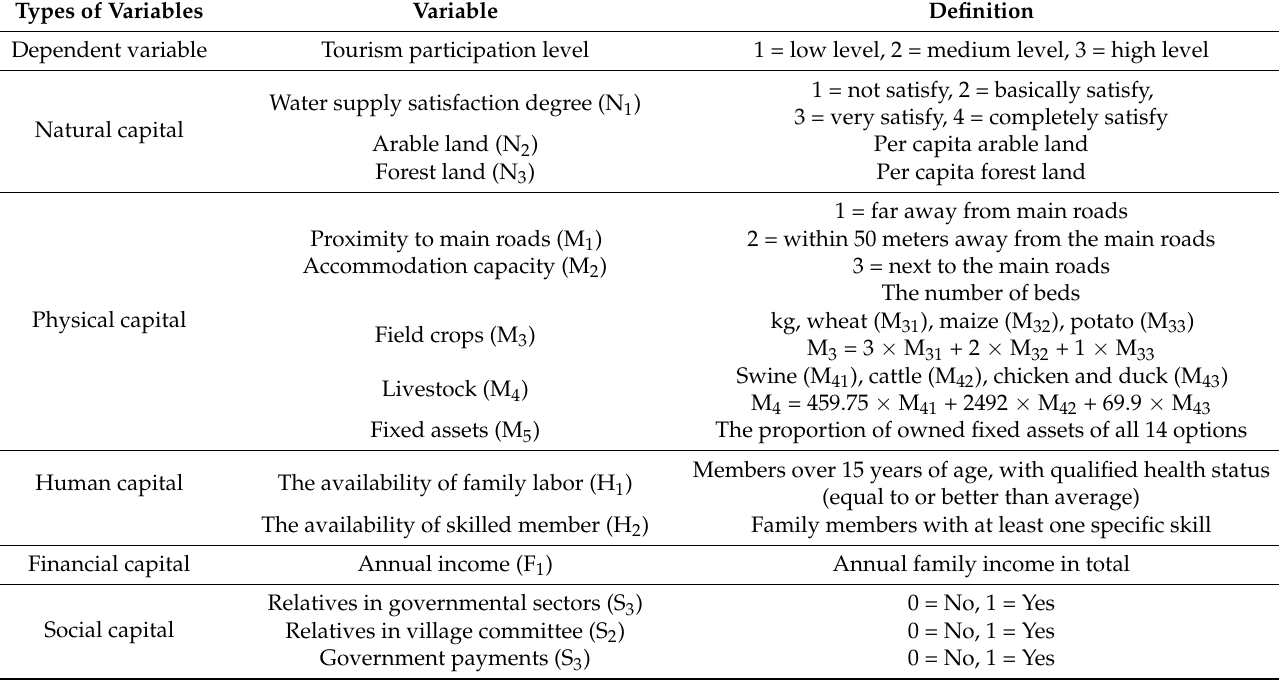
Table 1. Names and definitions of